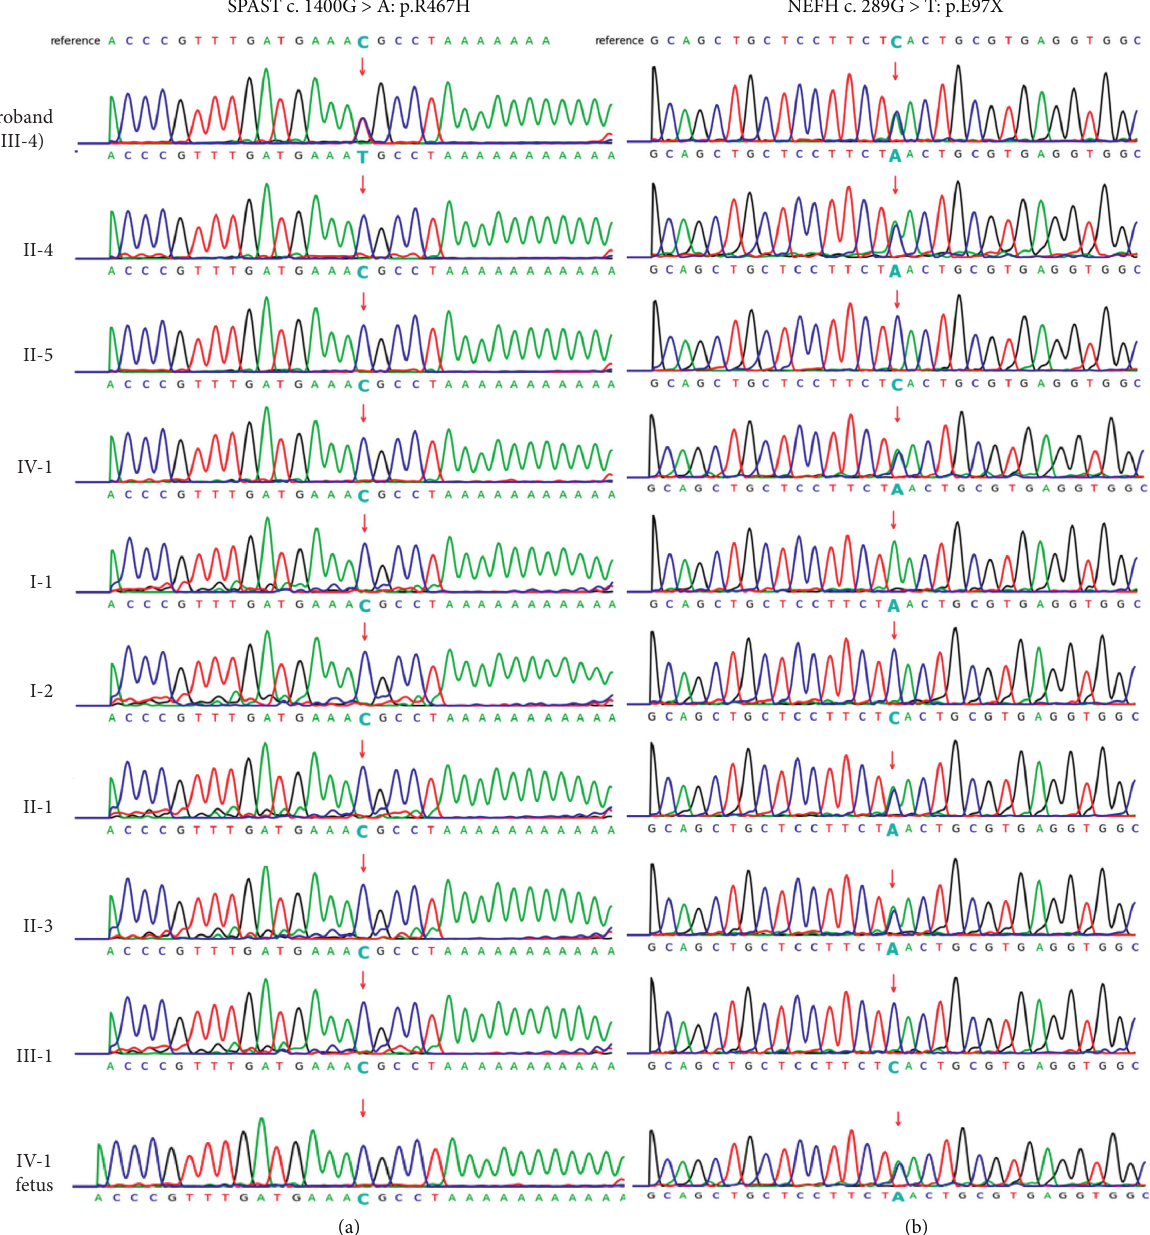
Figure 2: Sanger sequencing results of the SPAST and NEFH genes of the patient’s family. (a) Mutation in the SPAST gene in a Chinese family. (b) Mutation in the NEFH gene in a Chinese